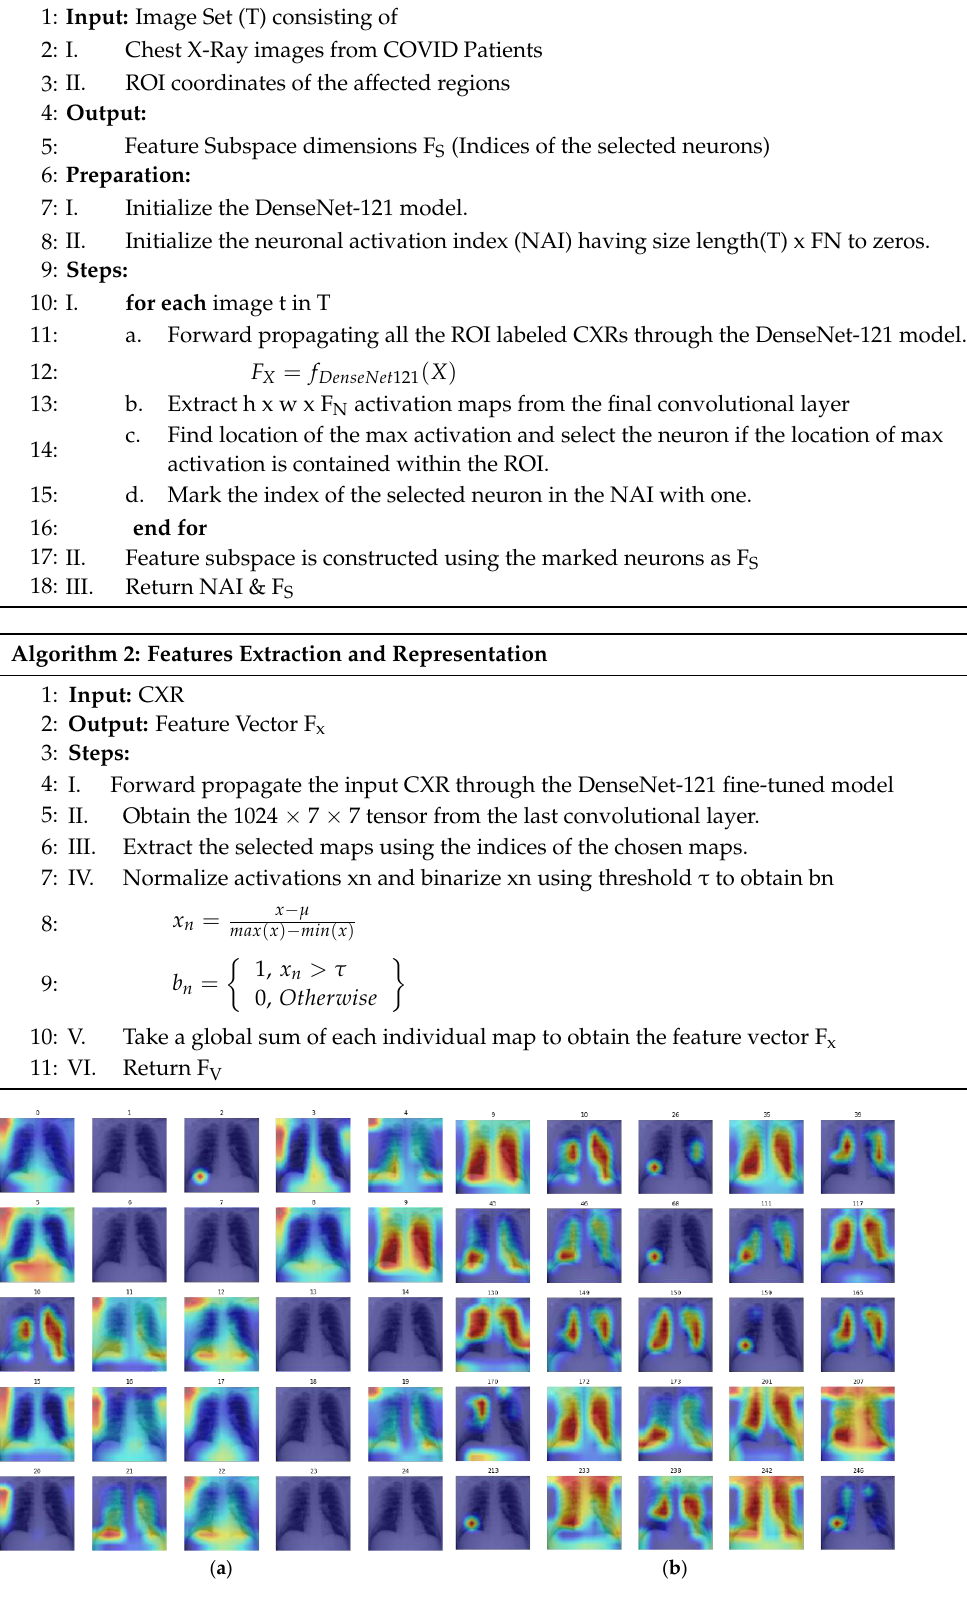
Figure 3. ( a ) First 25 feature maps from the last convolutional layer, ( b ) First 25 selected feature maps overlayed on the input image. The activations maps are then transformed into a feature vector using global average pooling where each feature map is averaged into a single value. This value corresponds to the strength of the feature for the input CXR. Higher values represent a strong presence, whereas lower values mean weaker presence of that particular feature. Since we are only selecting those features which are sensitive to infected regions, their presence and strength can be effectively determined by the feature vector. Sample feature vectors for both nor- mal and COVID-19 CXRs are provided in Figure 4. The features of COVID-19 CXRs are different than the features of a normal one. Furthermore, the similarity in features corre- sponds to the presence of similar pathologies in the CXRs since the feature space is con- structed by only considering infection sensitive neurons. Figure 4. Sample CXRs and their corresponding feature vectors.